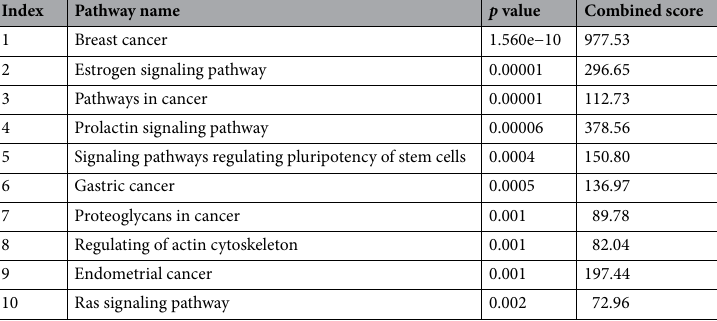
Table 3. Gene ontology analysis of potential target genes. GO terms with P value ≤ 0.01 were considered as the significant